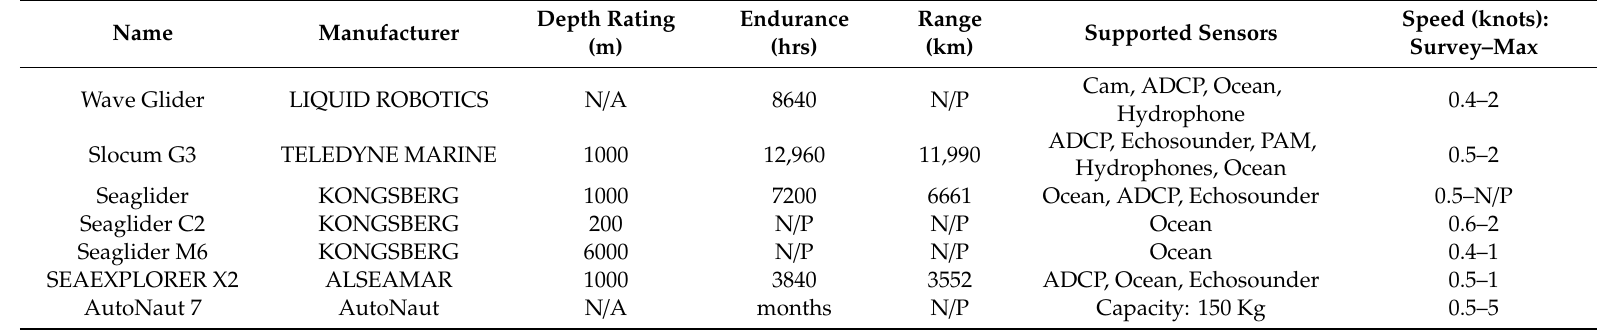
Table 4. UUGs (Unmanned Underwater Gliders) for carrying underwater sensors to survey the underwater environment of communication